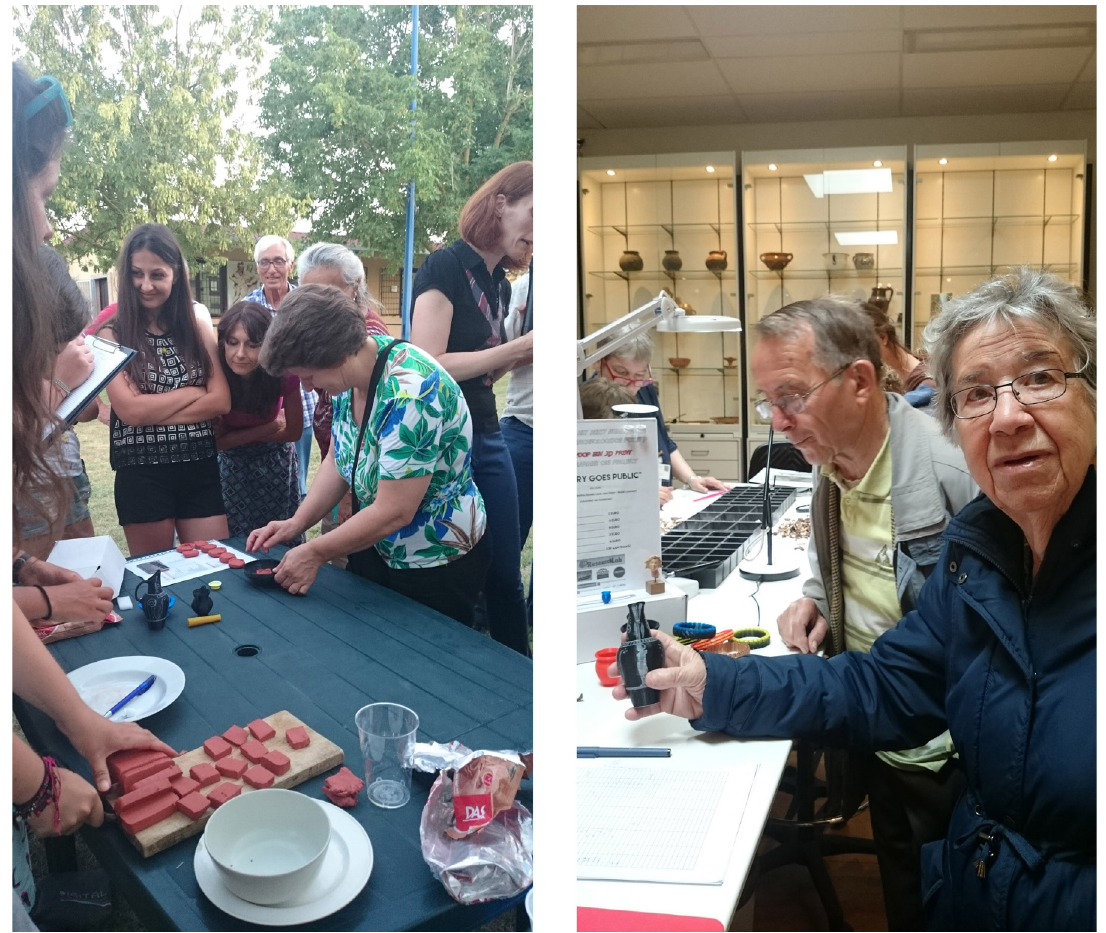
Figure 10. Left: Inhabitants from Le Ferriere portrayed when stamping. Right: Everybody loves 3D prints. Photos by L.